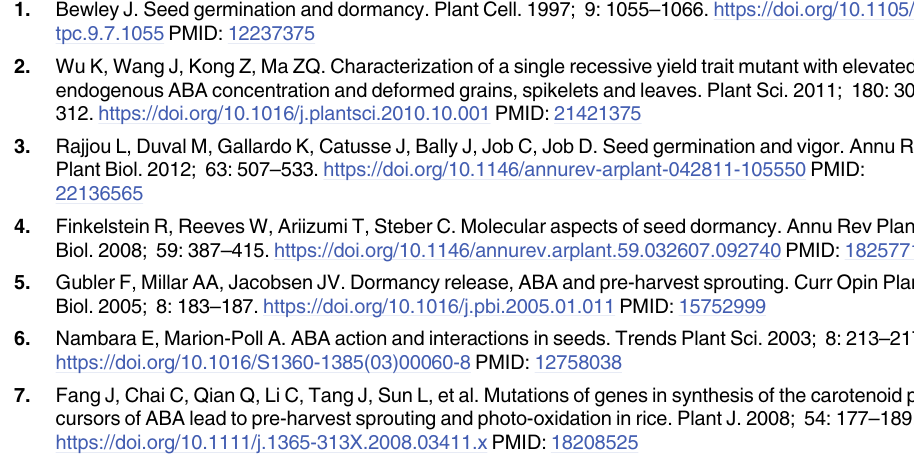
S4 Fig. Subcellular localization analysis of OsKO1 and OsKO2 with their full length CDS fused with GFP protein. The GFP containing vector was used as control. Scale bars = 2.5 μ m. (PDF) S5 Fig. RNA-seq and 2-DE analyses on the mutant and wild type rice. (A) Volcano plots showing the differentially expressed genes between wt and m (upside image), and m and m +GA (bottom image). mGA stands for m+GA. (B) Verification of the RNA-seq results through qRT-PCR on the selected genes in GA biosynthesis and ABA signaling pathways. (C) 2-D gel images of wt and m embryos. U and D indicate the up- and down-regulated proteins in mutant, respectively.